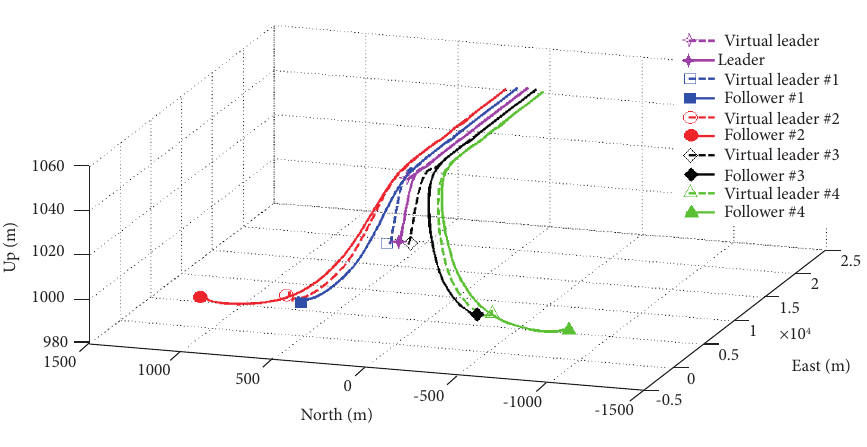
Figure 9. Straight maneuver in East direction without altitude